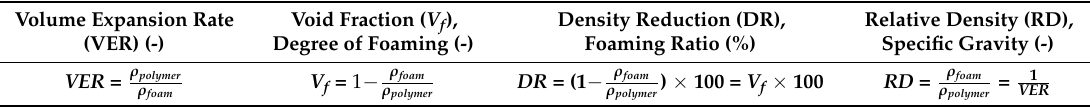
Table 3. Overview of terminologies to express foam expansion frequently used in the literature. Volume Expansion Rate Void Fraction ( V f ), (VER) (-) Degree of Foaming